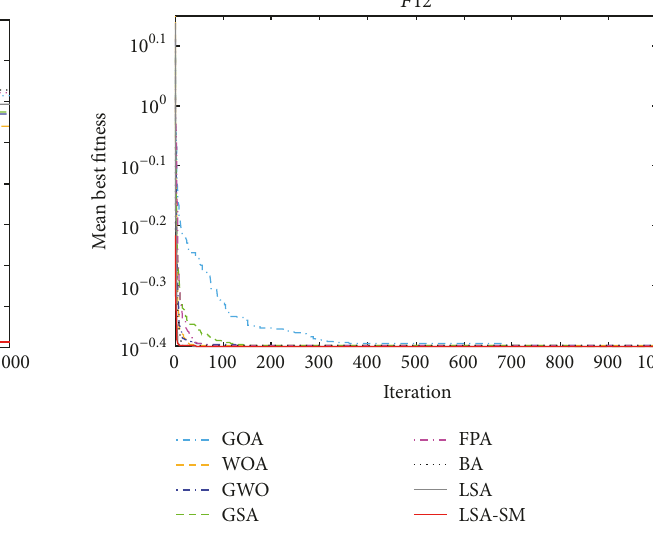
Figure 16: 𝐷 = 2 , convergence curves for 𝑓 12 .